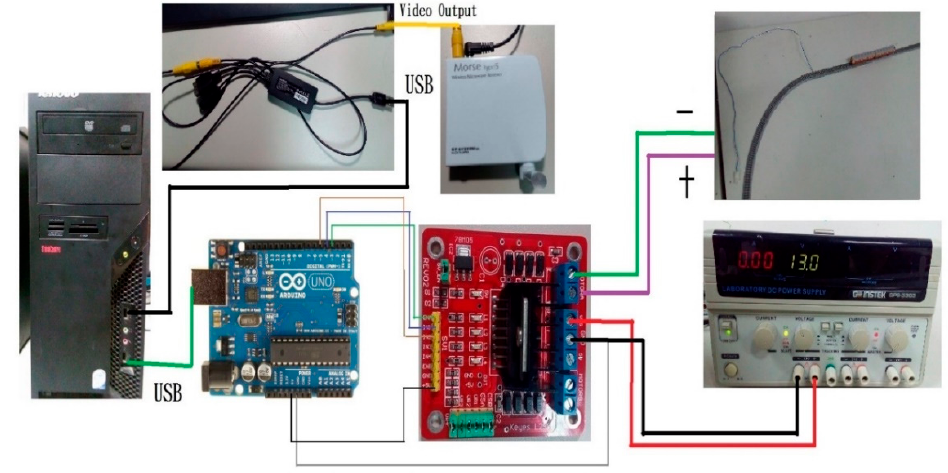
Figure 6. The experiment facility.